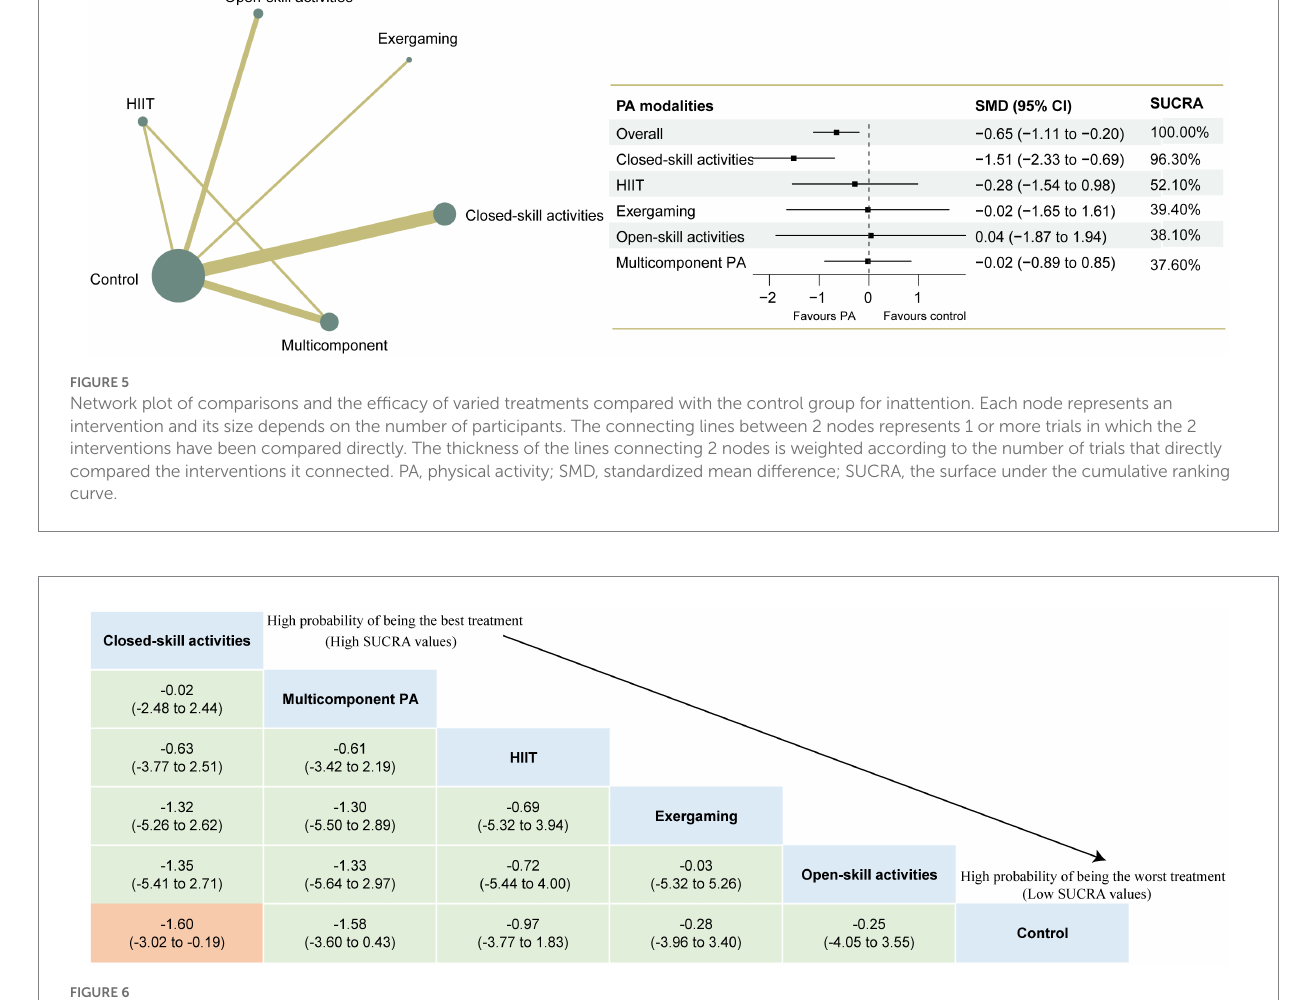
FIGURE 6 League table of outcome analyses for hyperactivity/impulsivity. PA, physical activity; SUCRA, the surface under the cumulative ranking